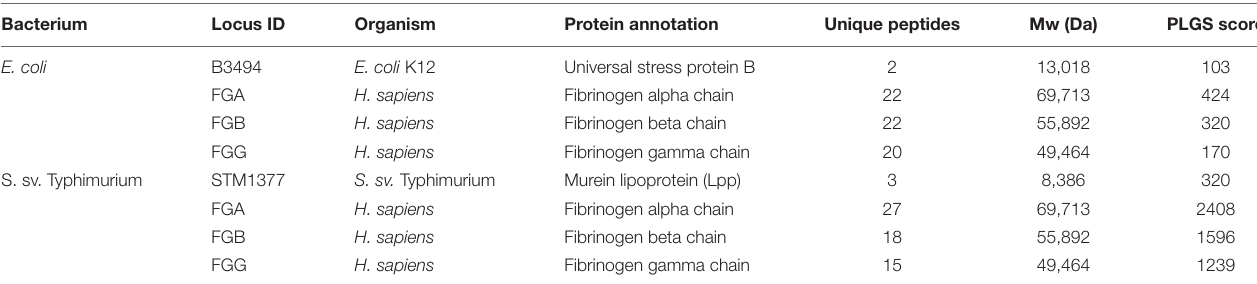
TABLE 2 | Fibrinogen-binding protein identified in E. coli and S. sv. Typhimurium after cross-linking.